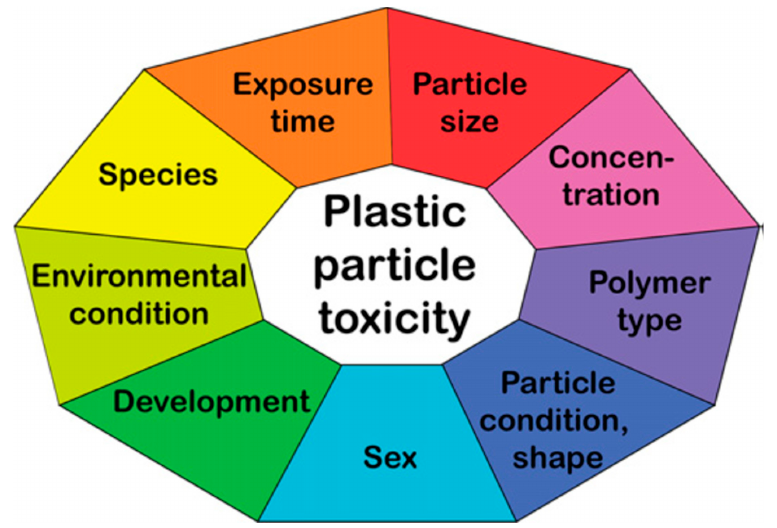
Figure 1. The nine main plastic particle toxicity determining factors, as found in the review. Kögel et al. (2020) [41] (open access). (2020) [41] (open